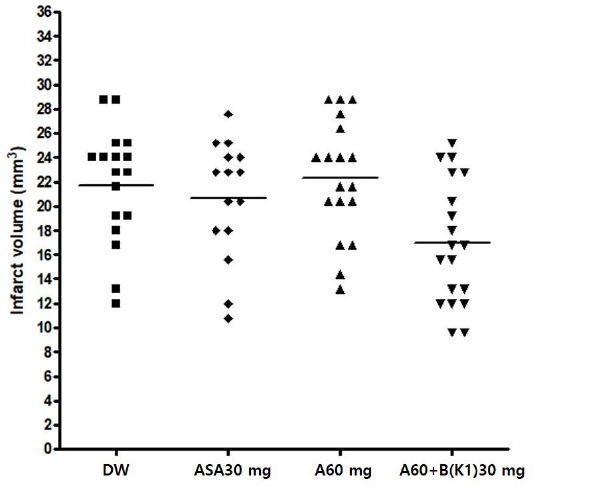
8 Table 5. Effects of experimental drug A60+B(K1) 30 mg/kg on infarct volume after pMCAO. Variables